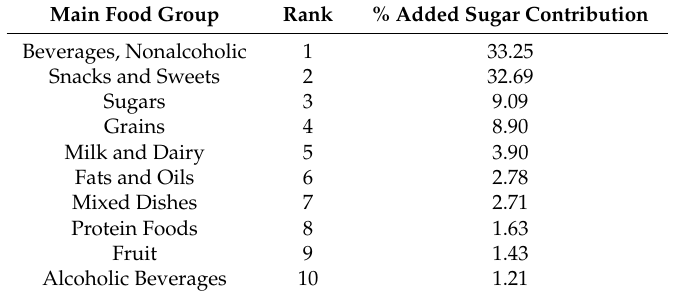
Table 15. Food sources of added sugars contribution in the total U.S. diet, adults ≥ 51 years old ( n = 4522; gender combined; daily intake data; NHANES 2011–2014; main food groups contributing <1.0% not reported; data are Day 1 intakes).